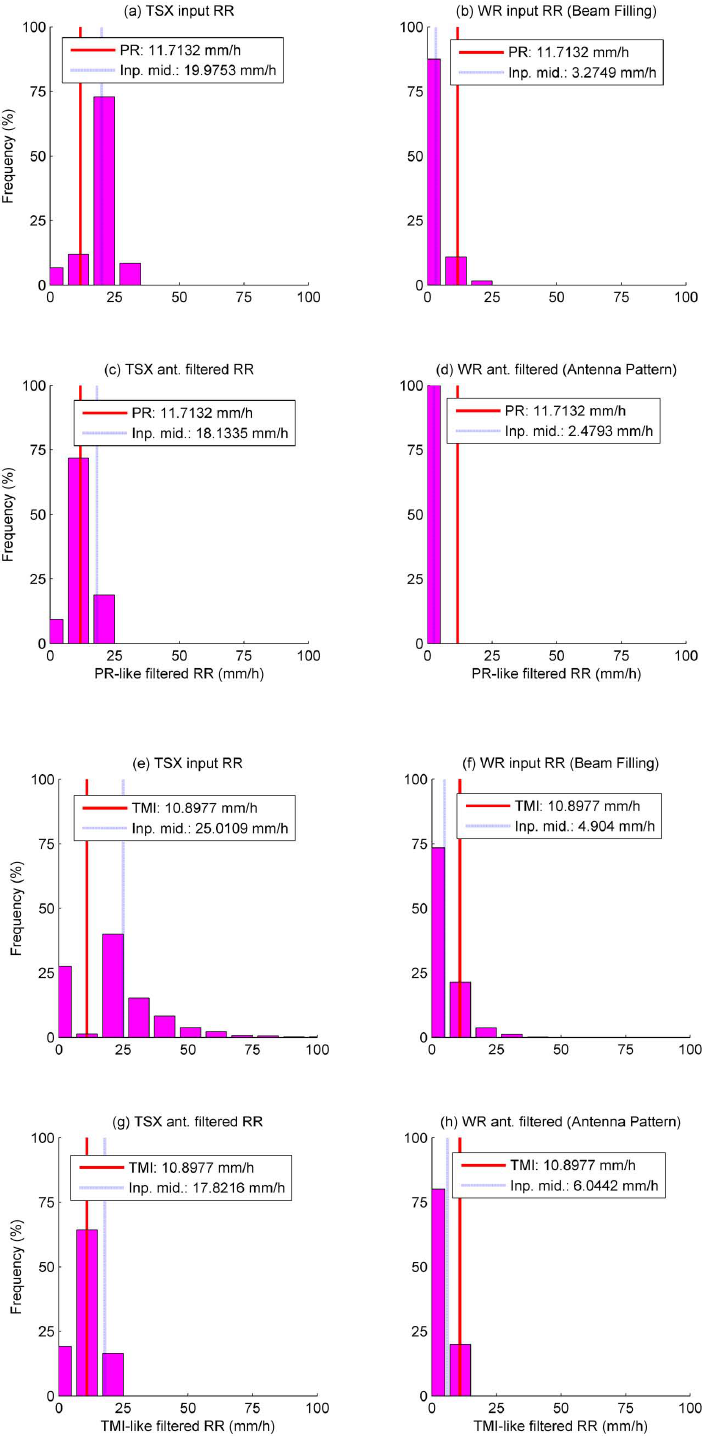
Fig. 9. Effects of the inhomogeneous beam filling and antenna pattern on PR-like and TMI-like rain rate estimation within the pixel area centered at about 31.00 ◦ N × 89.96 ◦ W (low precipitation area). The plots show the histogram of TSX (a, e) and WR (b, f) estimated rain rate (mmh − 1 ) within the EFOV area, with – bottom, (c, g) for TSX and (d, h) for WR – and without (top) the Gaussian filter which simulates the antenna pattern. The red bars represent the corresponding PR-like and TMI-like estimated rain rates (mmh − 1 ), while the dotted blue line represents the TSX/WR value around the middle of simulated